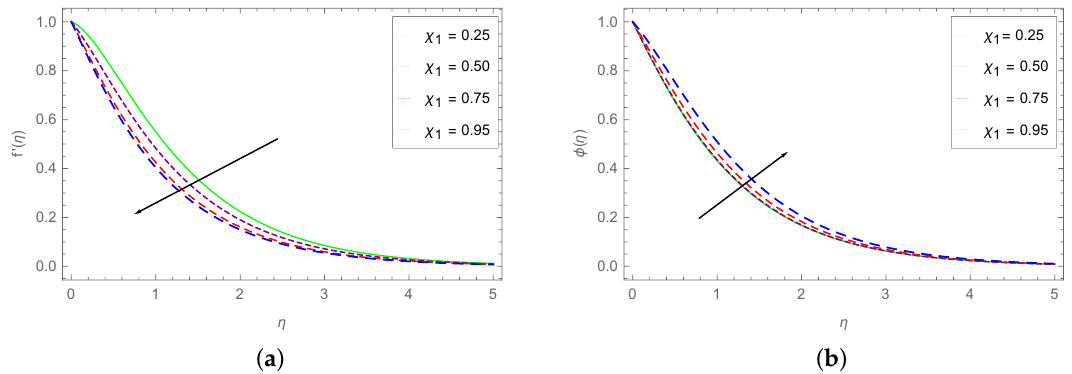
Figure 5. ( a ) f (cid:48) ( η ) dependence on (cid:36) and ( b ) dependence of f (cid:48) ( η ) on n . (cid:48) ( η ) and φ ( η ) (fluid concentration) with the enhancing values The variation in f of χ 1 are displayed respectively in Figure 6a,b. The different values of χ 1 used are (cid:48) ( χ 1 = 0.25, 0.50, 0.75, 0.95. From Figure 6a, it is observed that at a given χ 1 , f η ) changes (cid:48) ( η ) is faster at lower η in comparison with larger inversely with η . The rate of decline of f (cid:48) ( η values. Furthermore, by augmenting the values of χ 1 , the f η ) profiles drop to smaller values. The spacing between the curves for different χ 1 reduces with larger values of χ 1 . The different curves overlap beyond η = 4.0. The concentration field ( φ ( η ) ) variation with changing χ 1 is depicted in Figure 6b. It can be seen that at fixed χ 1 , the concentration field drops with enhancing η . The rate of decline of φ ( η ) is much larger at smaller η values. An enhancement in the φ ( η ) profiles is observed with the rising χ 1 . The rate of enhancement of φ ( η ) is larger for the larger χ 1 . The φ ( η ) curves for different χ 1 overlap with one another beyond η = 3.6.